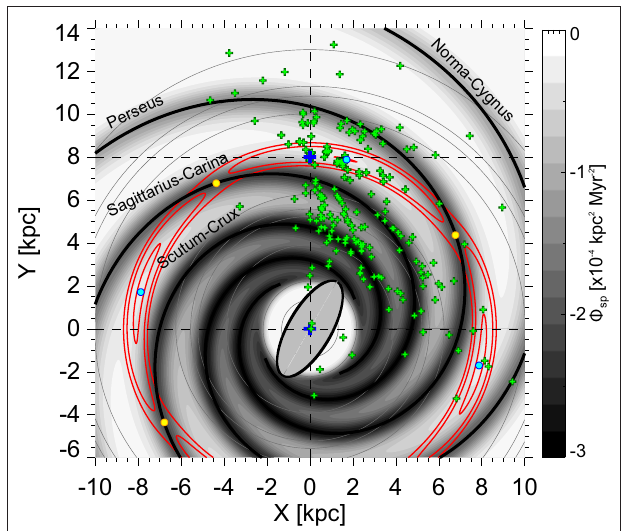
FIGURE 2 | Schematic representation of the Galactic X – Y plane. The effective potential of Equation (14) is represented by the gray levels, with the spiral potential (Equation 5) shown in gray background and its intensity indicated by the color bar in units of kpc 2 Myr − 2 ; the banana-like levels of the effective potential, shown in red, emphasize the corotation zones. Green crosses indicate the distribution of masers sources on the Galactic plane. The black logarithmic spiral curves indicate the loci of the main spiral arms (the minima of the spiral potential). The blue crosses indicate the positions of the Galactic center and the Sun, at ( X , Y ) = (0,0)kpc and (0,8.0)kpc, respectively. The cyan dots represent the Lagrangian points L 4 and L 5 , and the yellow dots represent the Lagrangian points L 1 and L 2 . The central ellipse is only a schematic view of the central bar, which is not included in our Galactic model. Adapted from Lépine et al.